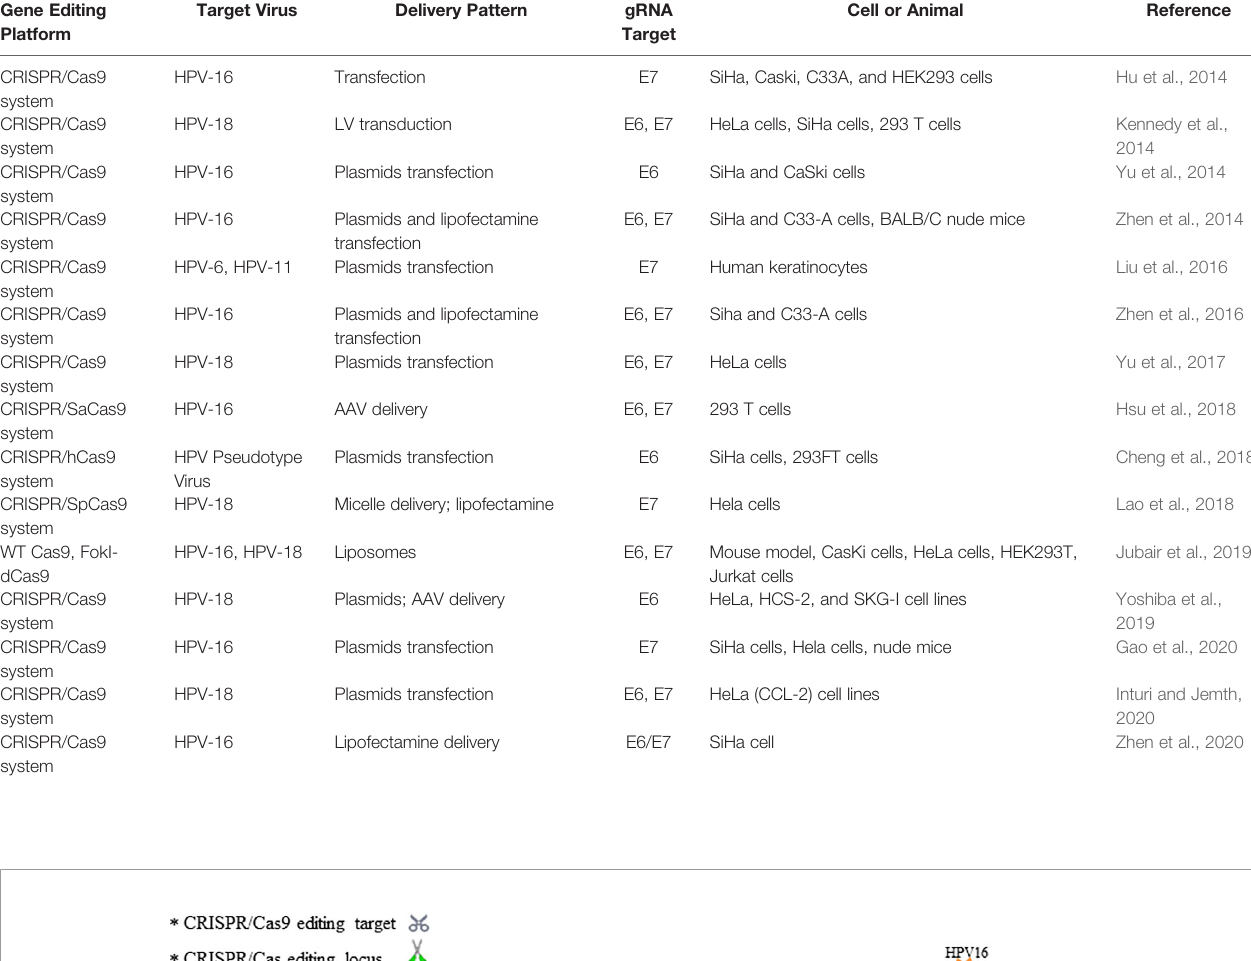
TABLE 2 | List of CRISPR/Cas9-based antiviral studies on targeting